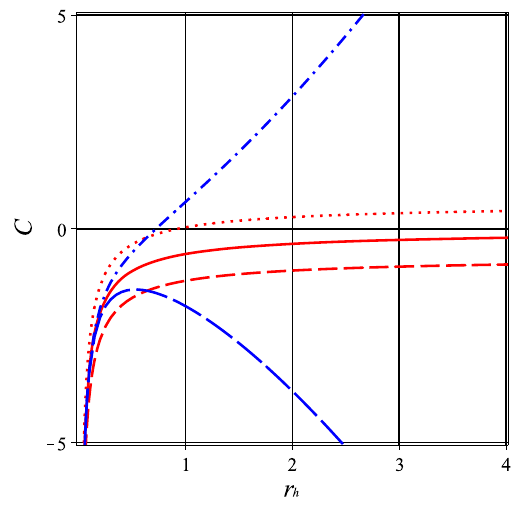
= − 0 . 5 ( blue long dash ) 1